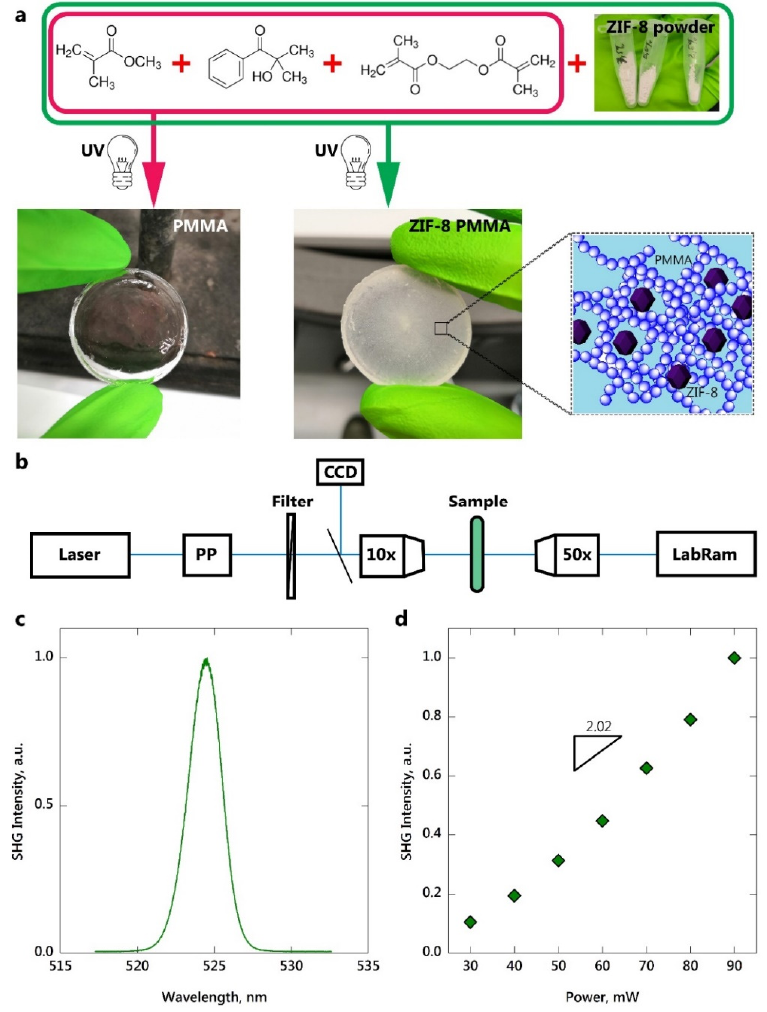
Figure 1. ( a ) Schematic illustration of ZIF-8– polymethyl methacrylate (PMMA) composite synthesis. ( b ) Optical scheme of imaging of the composite and analysis of SHG intensity. PP - pulse picker